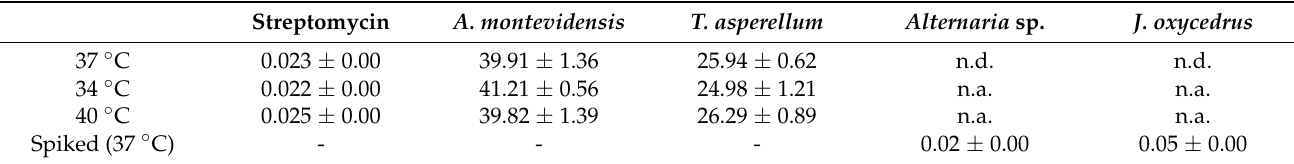
IC 50 values ( µ g/mL) of crude extracts and the positive control streptomycin (spiked) given as mean values ± standard deviations of individual experiments conducted on three consecutive days.